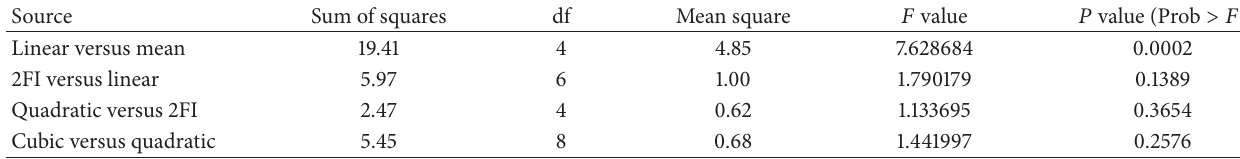
Table 2: ANOVA results of the experimental results fitting to different models.